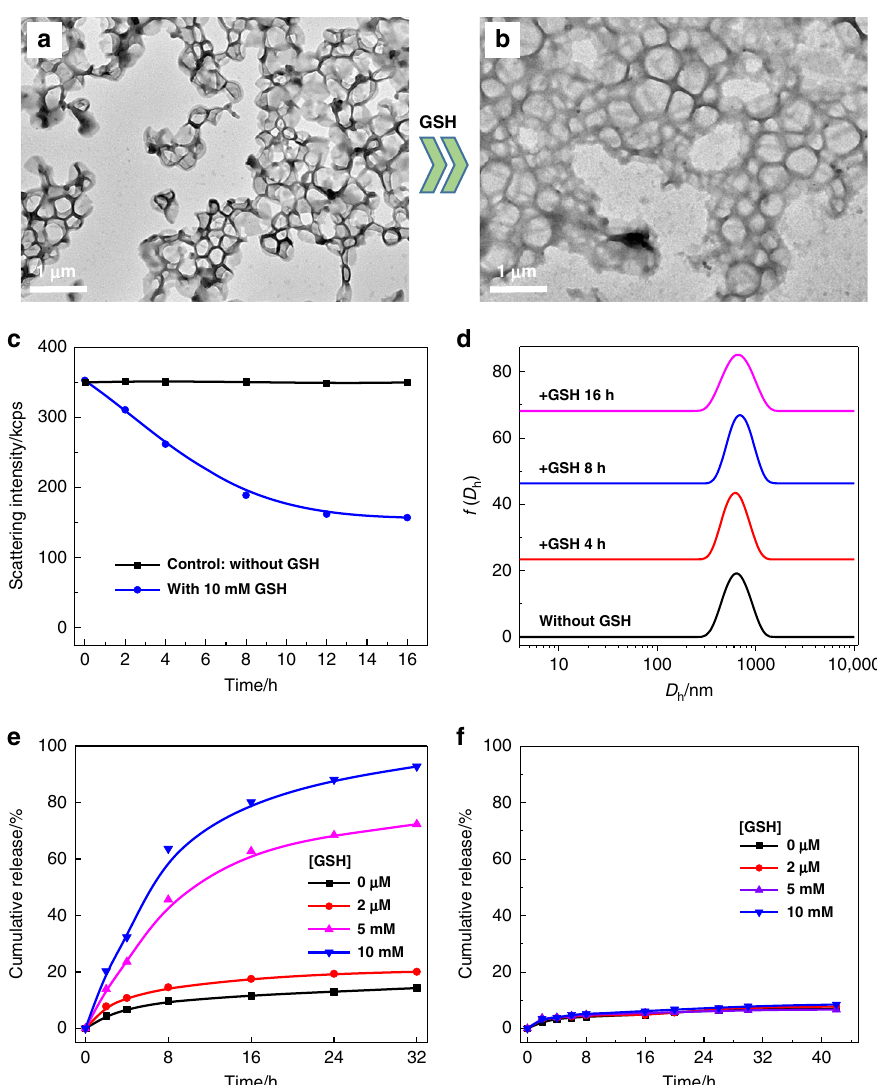
Fig. 10 Reduction-triggered polymersome-to-PICsome transition and permselectivity regulation. a , b TEM images recorded for reductive milieu- responsive PEO 45 - b -P(DCMA 0.45 - co -PDPA 0.55 ) 33 vesicles a before and b after treating with 10 mM GSH in neutral aqueous media. c , d Incubation time- dependent evolution of c scattered light intensities and d intensity-average D h distributions upon treating with 10 mM GSH. e , f Release pro fi les of e 5-Fu and f Dox·HCl from aqueous interiors of vesicles before and after treating with GSH at varying concentrations. All scale bars represent 1 μ m. All data were obtained at a polymer concentration of 0.1 g/L in PB buffer (pH 7.4, 10 mM, 37